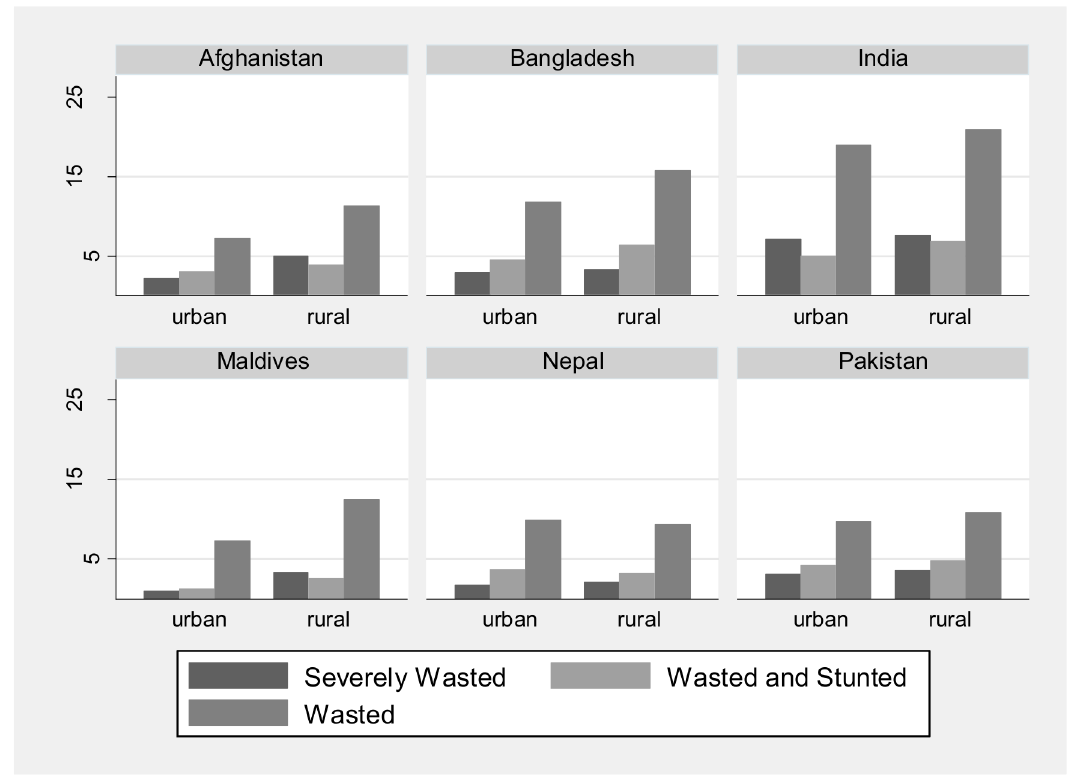
Fig 3. Percent of children wasted, wasted and stunted, and severely wasted across urban and rural, by country.